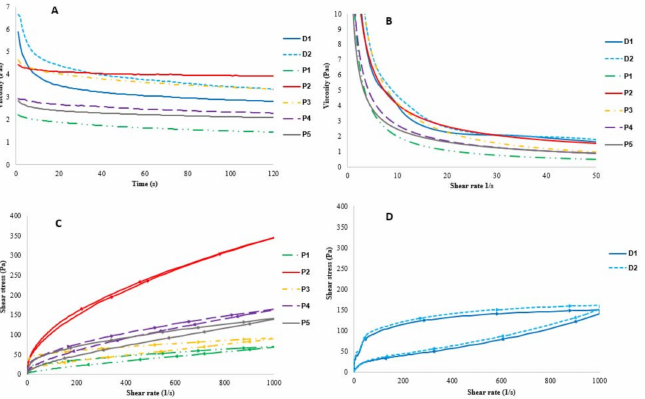
Figure 2. ( A ) Viscosity (Pa · s) during 120 s at a steady shear rate of 10 s − 1 . ( B ) Flow curve: viscosity (Pa · s) by shear rate (s − 1 ). ( C ) Hysteresis loops in plant-based yogurts. ( D ) Hysteresis loops in dairy yogurts.